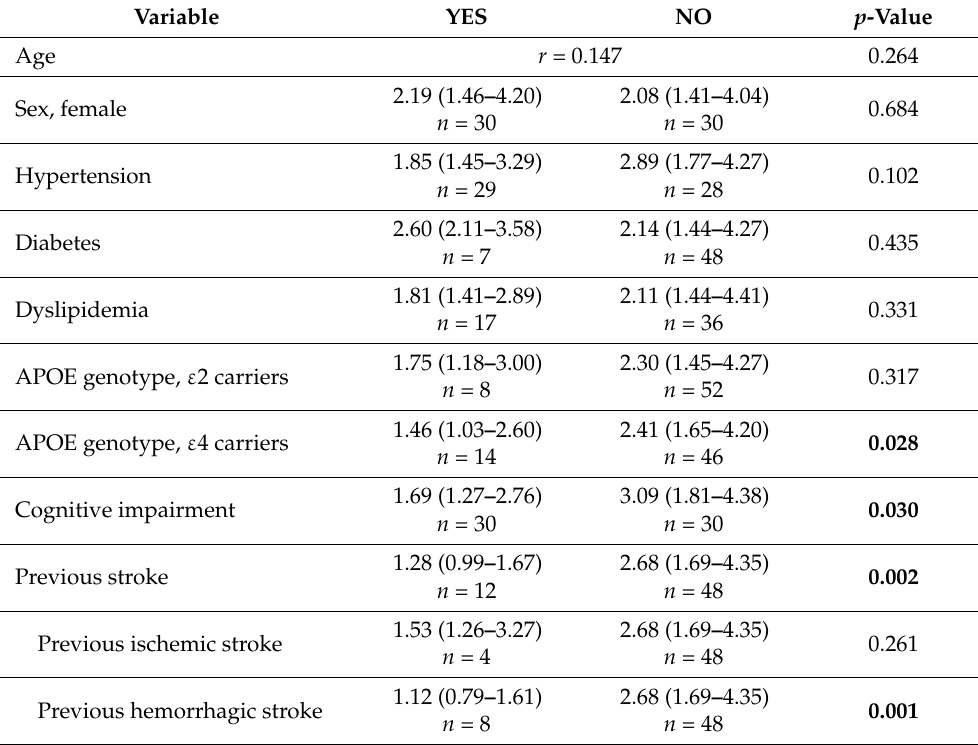
Table 3. Univariate analysis of AQP4 levels according to CAA–ICH demographic and clinical characteristics. Variable YES NO p